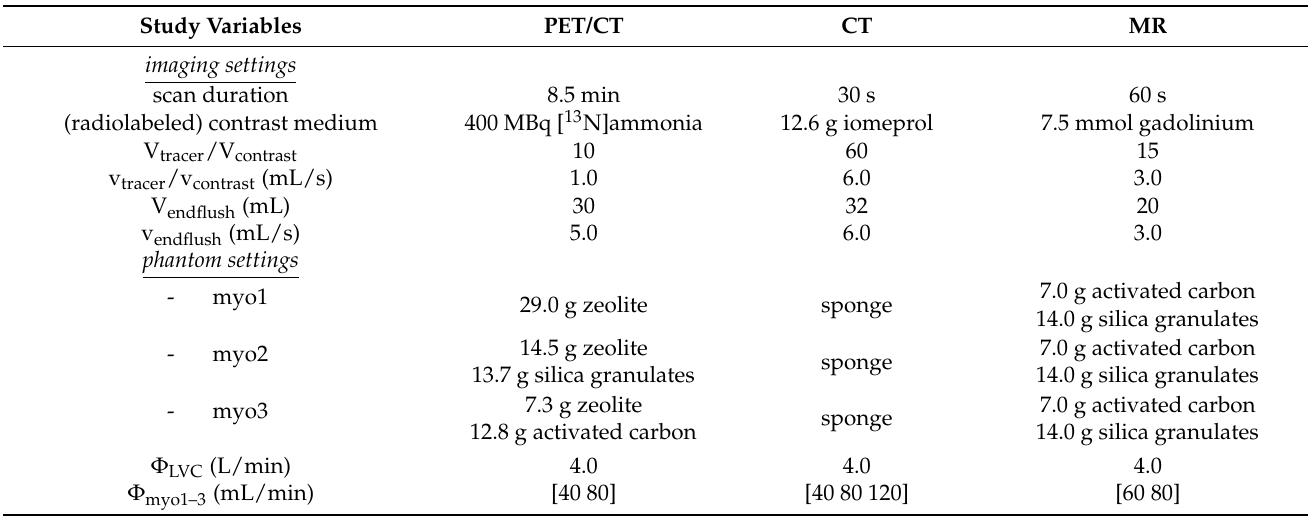
Table 1. Overview of study